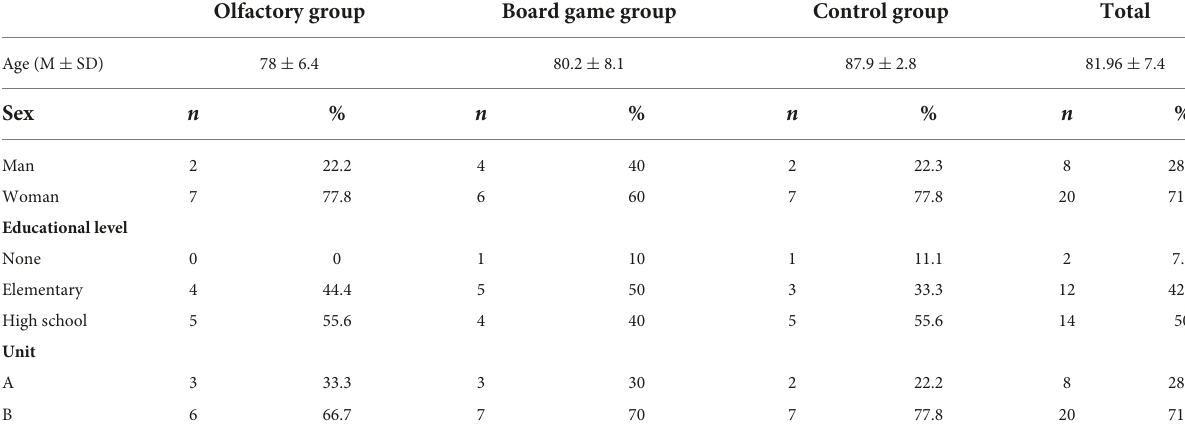
TABLE 1 Demographical background of participants. Olfactory group Board game group Control group